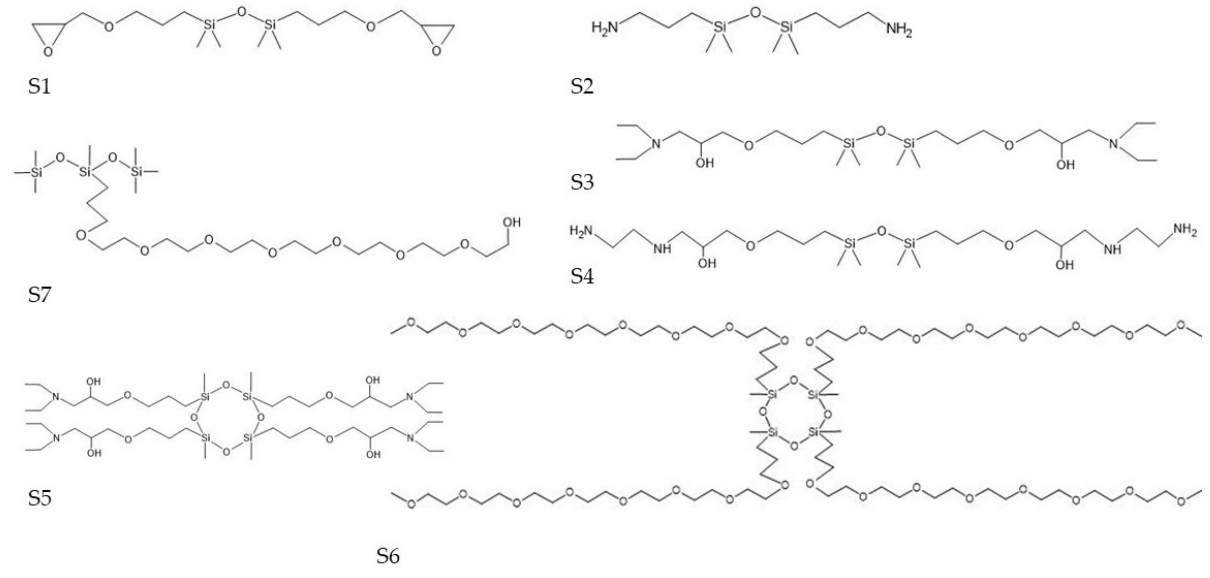
Figure 2. Chemical structures of siloxanes used for waterlogged wood conservation.